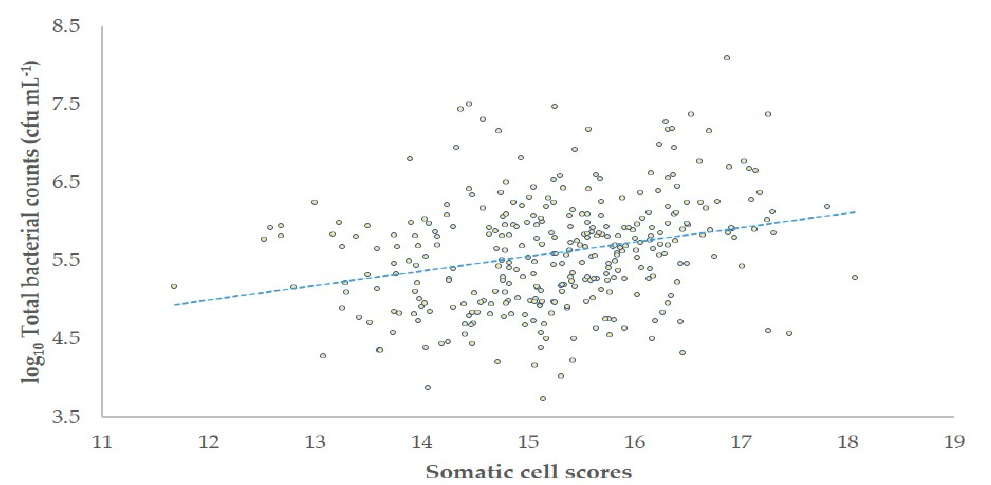
Figure 3. Somatic cell scores [log 2 (SCC/100) + 3] and total bacterial counts in the bulk-tank milk of 325 sheep flocks in Greece (cfu: colony-forming-units). Table 2. Isolation of staphylococci from bulk-tank milk of 325 sheep flocks in Greece and associa- tion with somatic cell counts or total bacterial counts in the milk.